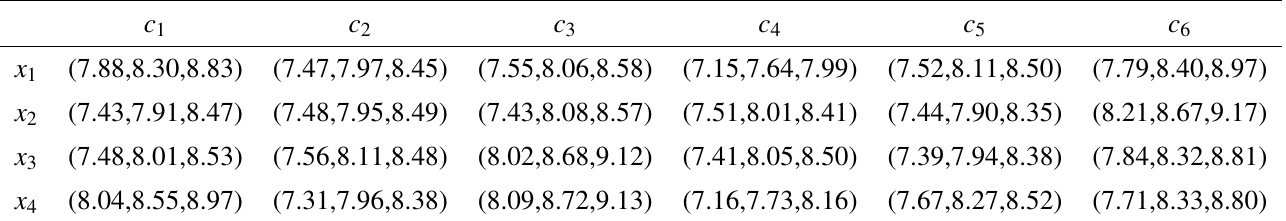
Table 6: The collective transformed individual decision matrix in the final decision